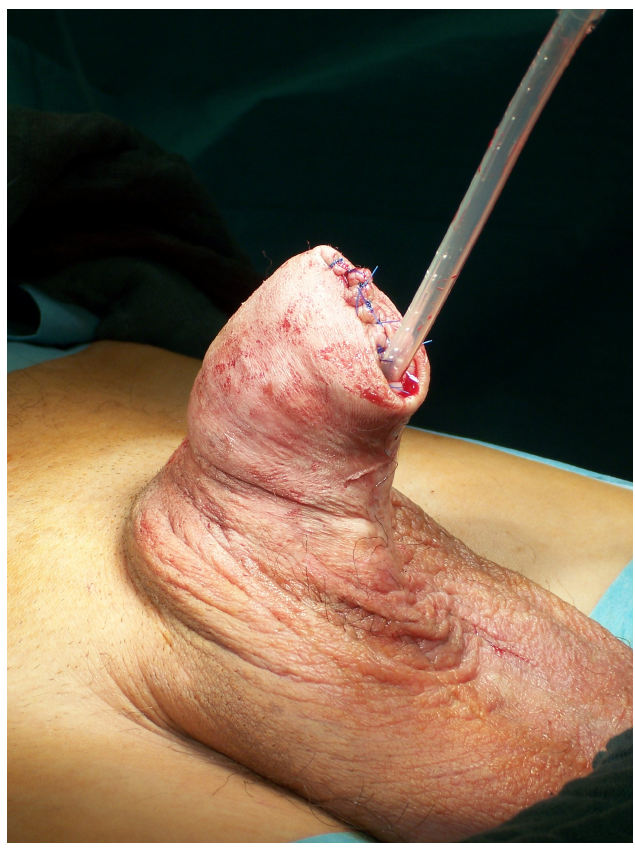
FIGURE 2. Postoperative view exhibiting the penis after partial penectomy.